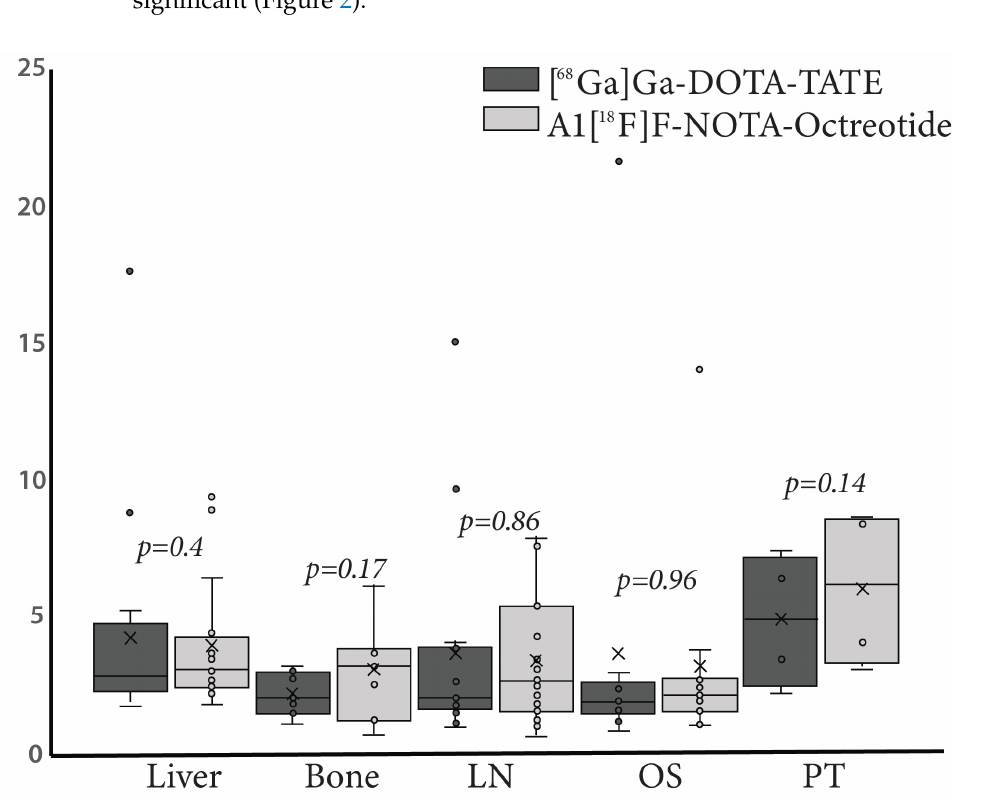
Figure 2. Tumour-to-liver ratio (TLR) of [ 68 Ga]Ga-DOTA-TATE (black bars) and Al[ 18 F]F-NOTA- Octreotide (grey bars) in different tissues. Right panel, boxplots representing TLR in liver, bone, lymph node (LN), other sites (OS) and primary tumour (PT). In each case outliers are represented as circles.